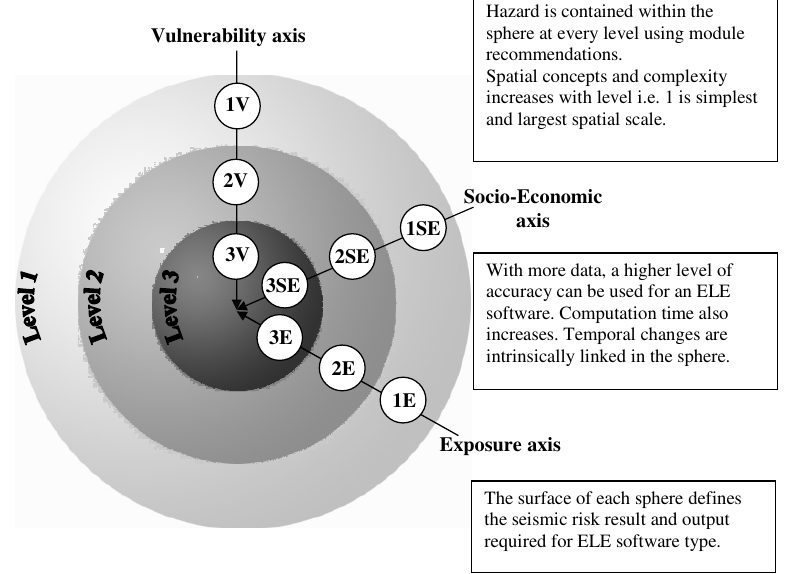
Fig. 6. Multi-level spatial complexity in the ELE software for the simplified MCA – Level 1=global (national), Level 2=grid type system Figure 6. Multi-level spatial complexity in the ELE software for the simplified MCA - Level 4 (large geocells), Level 3=city/district (small 1 = global (national), Level 2 = grid type system (large geocells), Level 3 = city/district (small 5